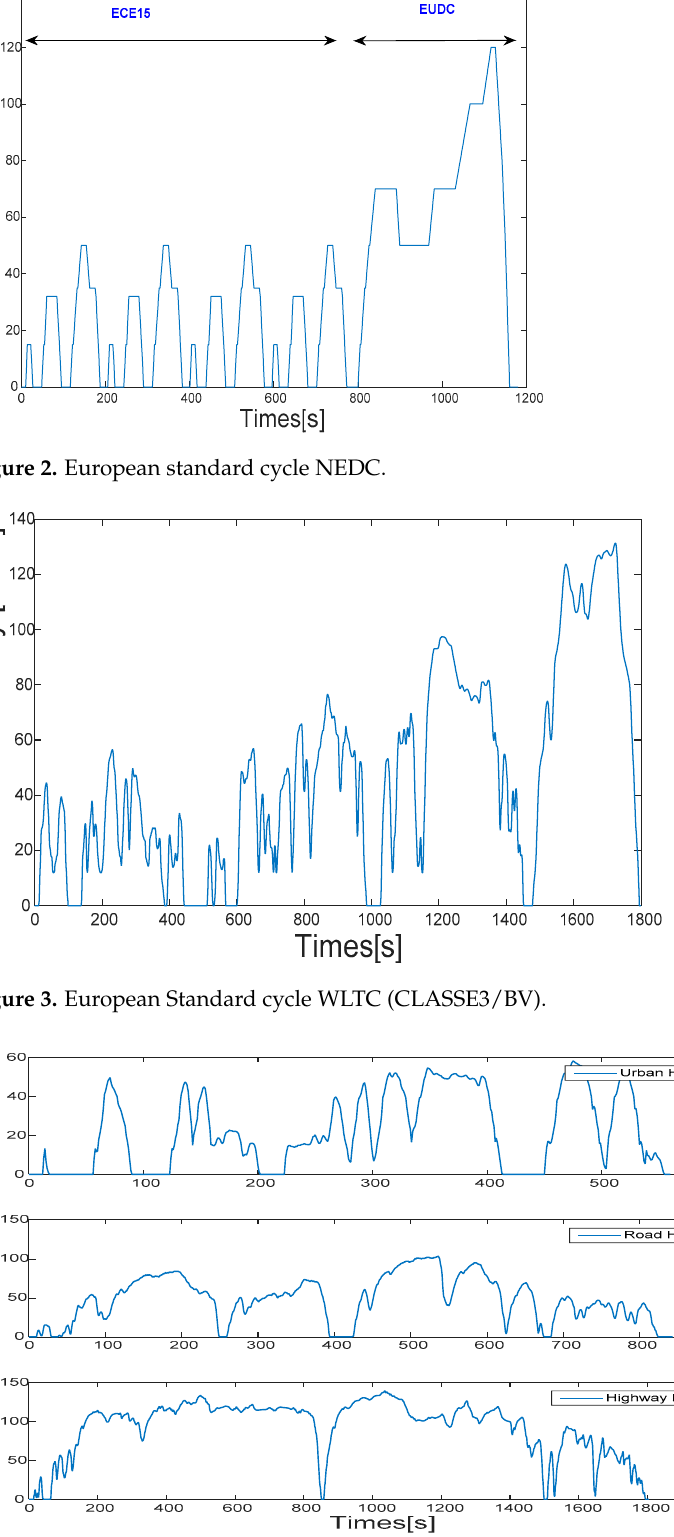
Figure 4. Urban Hyzem cycle, Road Hyzem cycle, and Highway Hyzem